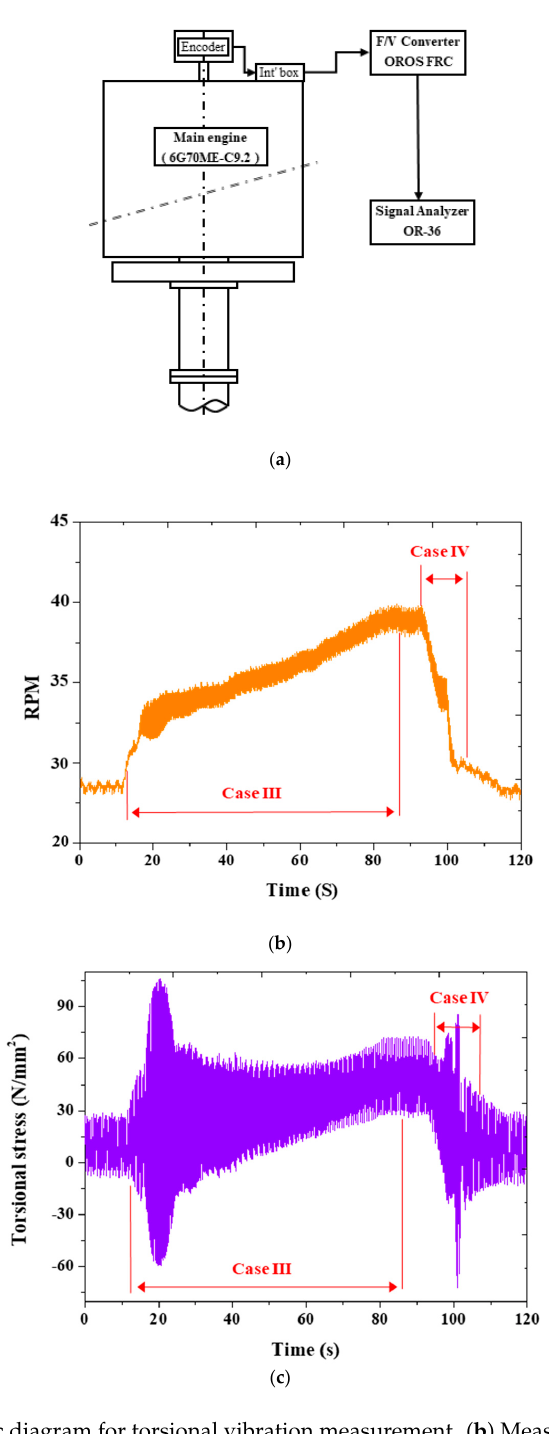
Figure 3. ( a ) Schematic diagram for torsional vibration measurement. ( b ) Measured result of duration time within barred speed range. ( c ) Measured result of torsional vibration in the intermediate shaft within the barred speed range equal to the transient